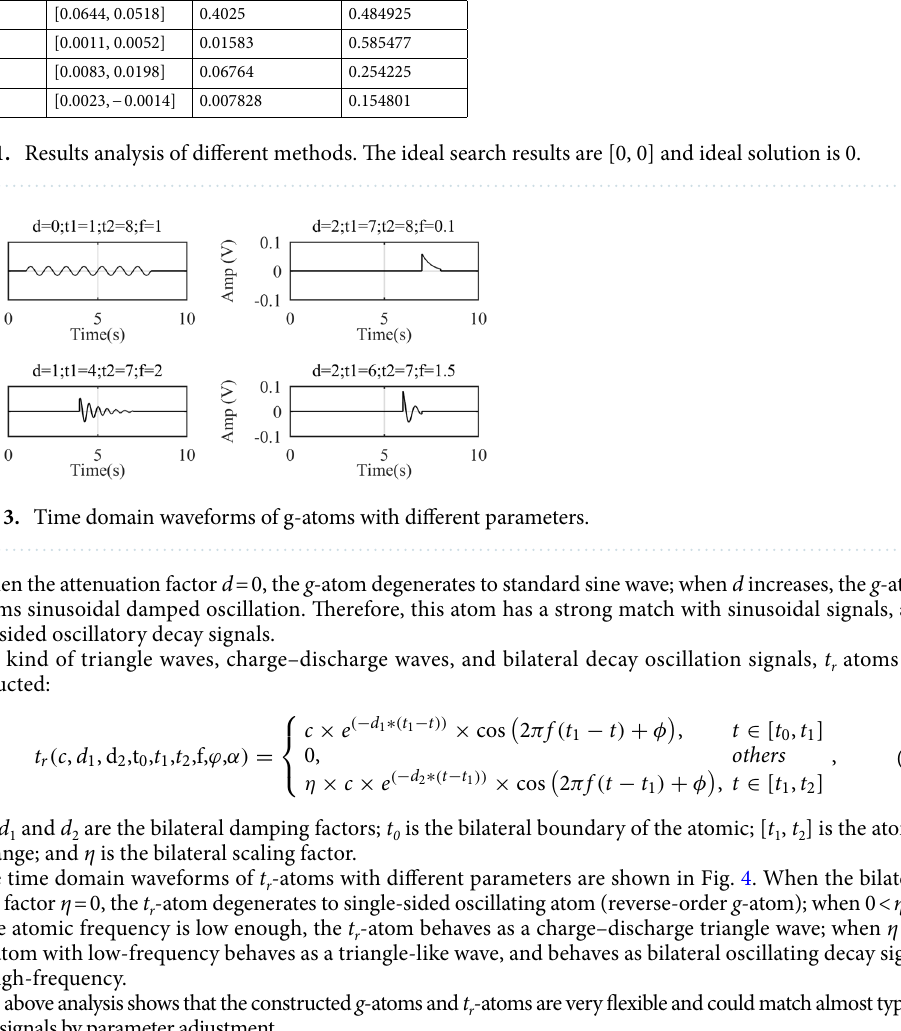
Figure 2. The optimal trajectory of different methods. ( a,b ) Show the 3D view and contour attempt of the optimal trajectory, respectively. Colors: black: the merit-seeking trajectories of PSO, blue: the merit-seeking trajectories of AFSA, green: the merit-seeking trajectories of CS, red: the merit-seeking trajectories of BA. Algorithm